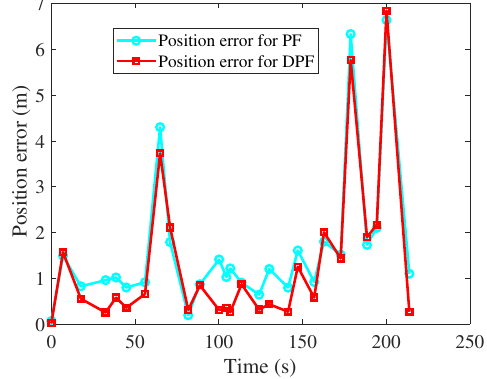
Figure 7. Position errors for DPF and PF.